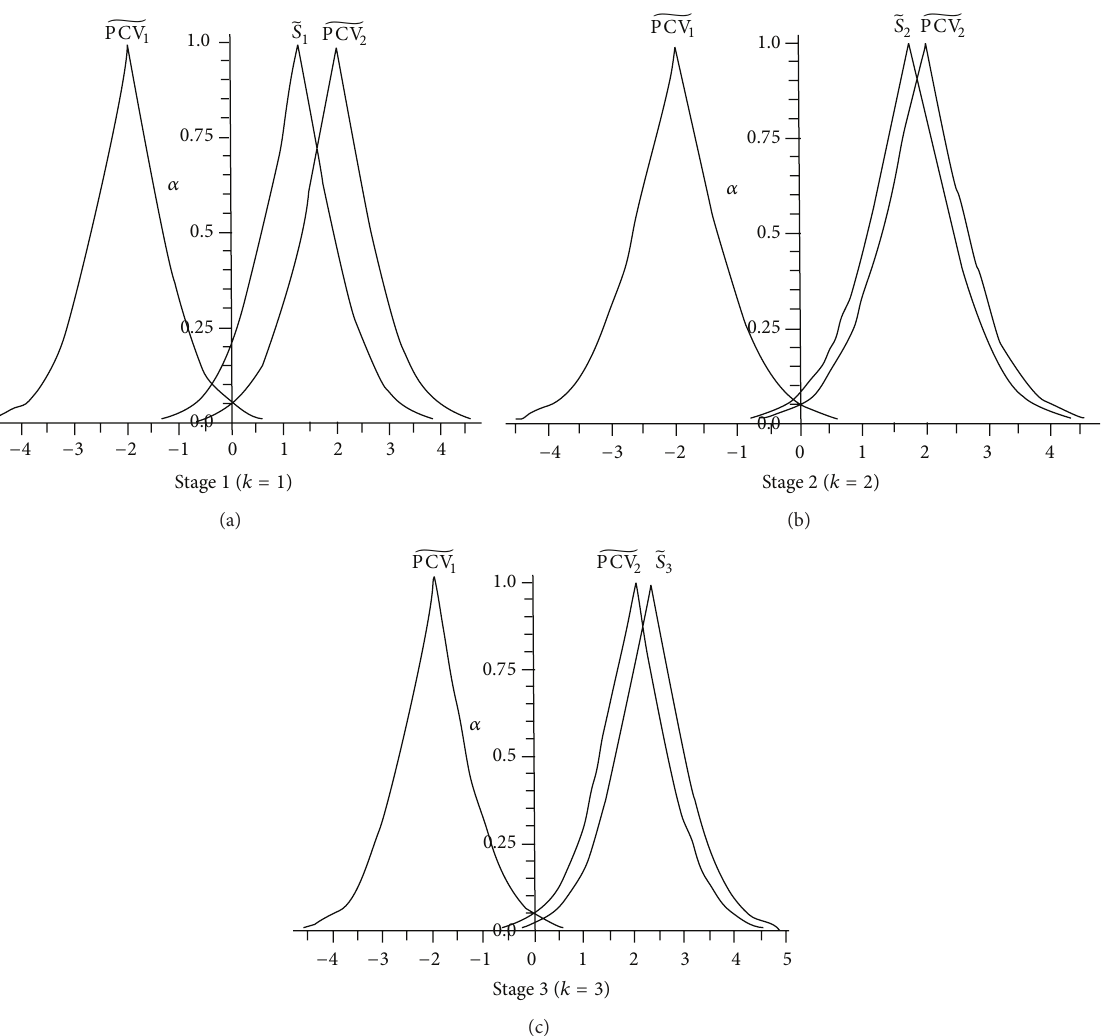
Figure 4: Summarized calculations for group sequential test using 𝛼 -cuts for 𝐾 = 3 , 𝑘 = 1,2, 3